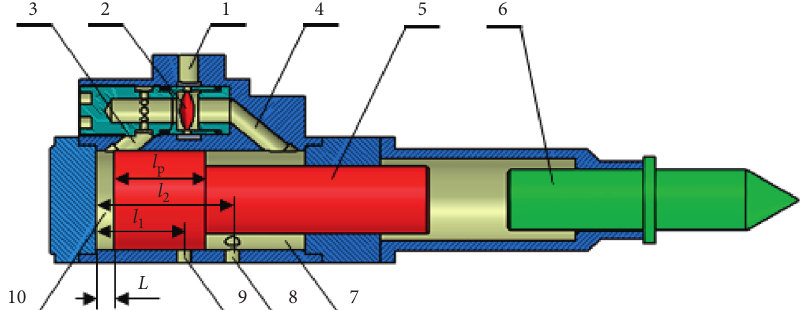
Figure 1: The structure of a small pneumatic hammer: 1. Inlet port; 2. Valve; 3. Stroke control port; 4. Return control port; 5. Piston; 6. Shank; 7. Front chamber; 8. The outlet in the front chamber; 9. The outlet in the rear chamber; 10. Rear chamber.